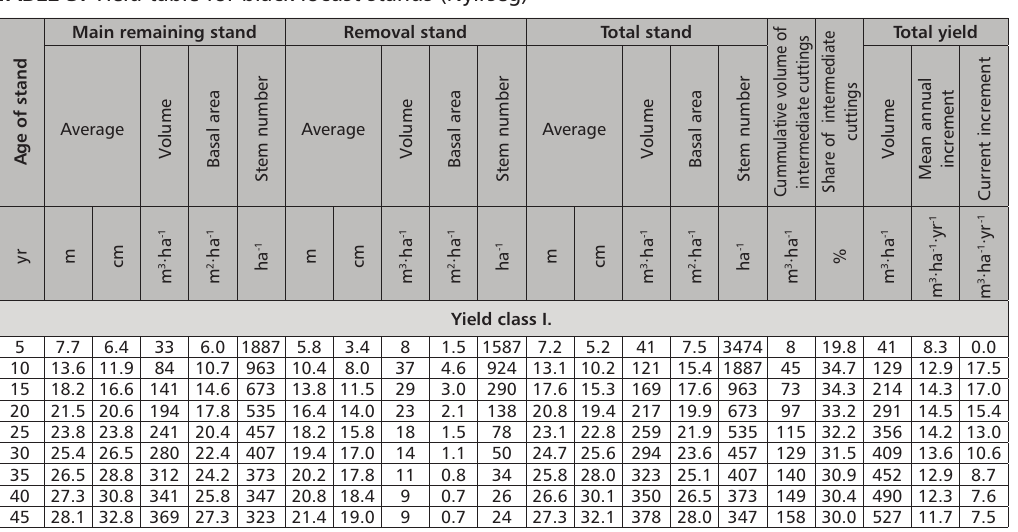
TABle 3. Yield table for black locust stands (Nyírség)